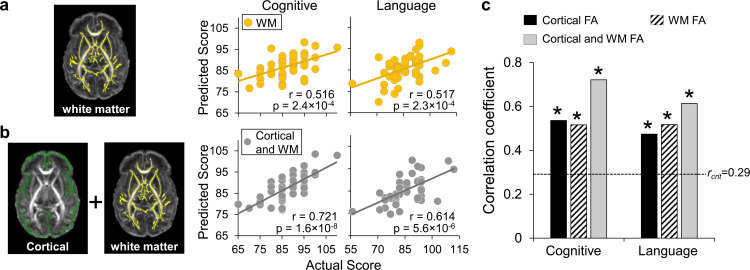
Prediction of neurodevelopmental outcomes using (a) white matter (WM) fractional anisotropy (FA) features only and (b) combined cortical and WM FA features, compared with prediction using cortical FA features.(a) On the left panel, WM microstructure was measured at the core WM regions, shown as yellow skeleton overlaid on a FA map of a neonate brain, to alleviate the partial volume effects. Feature vectors were obtained by measuring WM skeleton FA at 40 tracts transformed from WM labeling of a neonate atlas. On the right panel, scatter plots show linear regressions between actual scores and the predicted cognitive or language scores based on WM FA measures with LOOCV. (b) On the left panel, feature vectors were obtained by combining cortical skeleton (green) FA at 52 parcellated cortical gyri and WM skeleton (yellow) FA at 40 tracts with the labeling transformed from a neonate atlas. On the right panel, scatter plots show linear regressions between actual scores and the predicted cognitive or language scores based on both cortical and WM FA measures with LOOCV. (c) Significant correlation between the predicted and actual cognitive or language outcomes was found based on cortical FA only, WM FA only, and combined cortical and WM FA feature vectors. Dashed line indicates critical r value corresponding to p=0.05. * in the panel indicates significant (p<0.05) correlation.